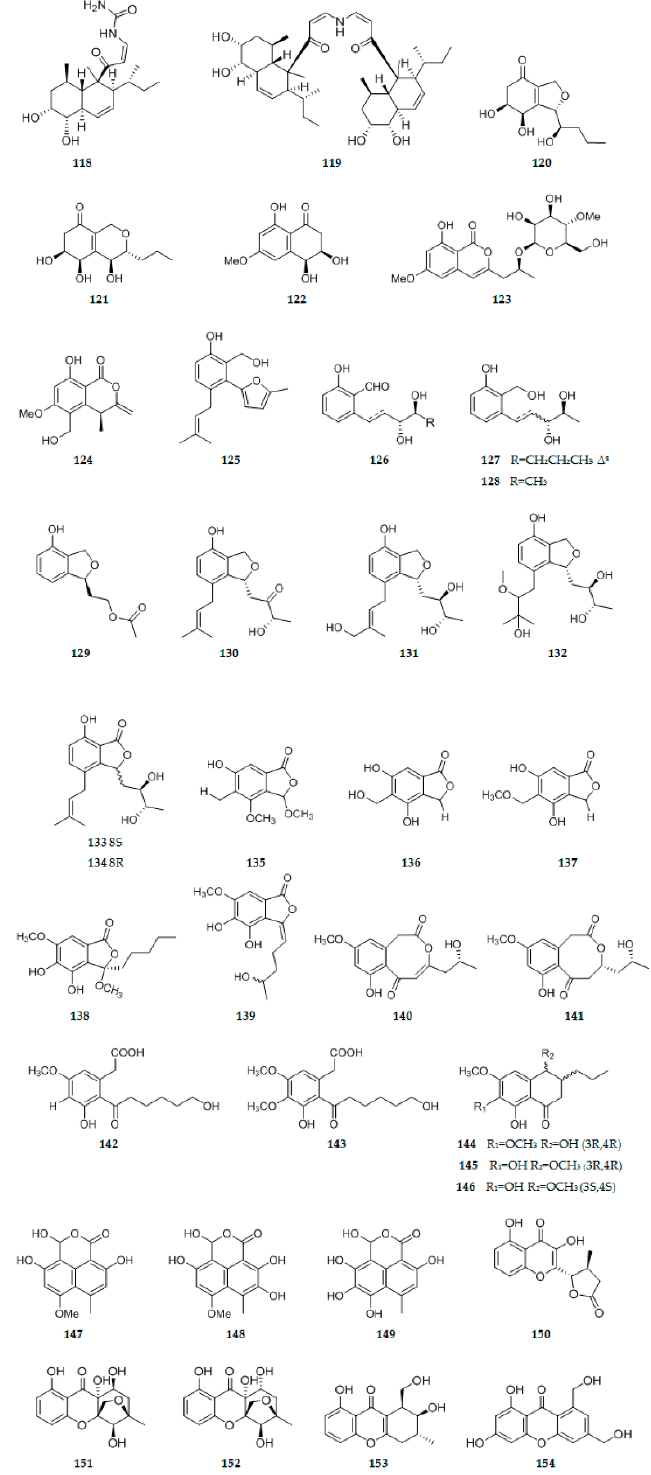
three new polyketides, phomopones A − C 181 – 183 (Figure 5) [55]. Three new polyketides including two benzophenone derivatives, penibenzones A ( 184 ) and B ( 185 ) (Figure 5), and a new phthalide derivative, penibenzone C 186 (Figure 5), were isolated from the solid-substrate cultures of the endophytic fungus Penicillium purpurogenum IMM003 [56].